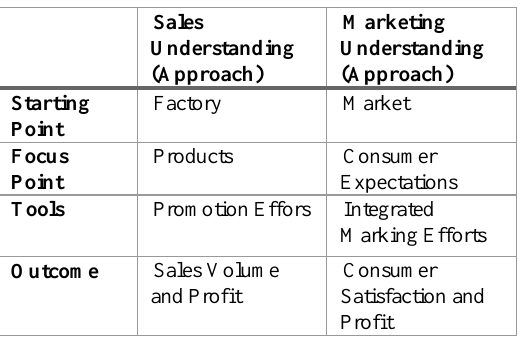
Table 1: Comparison of the Sales Understanding (Approach) and the Marketing Understanding (Approach)